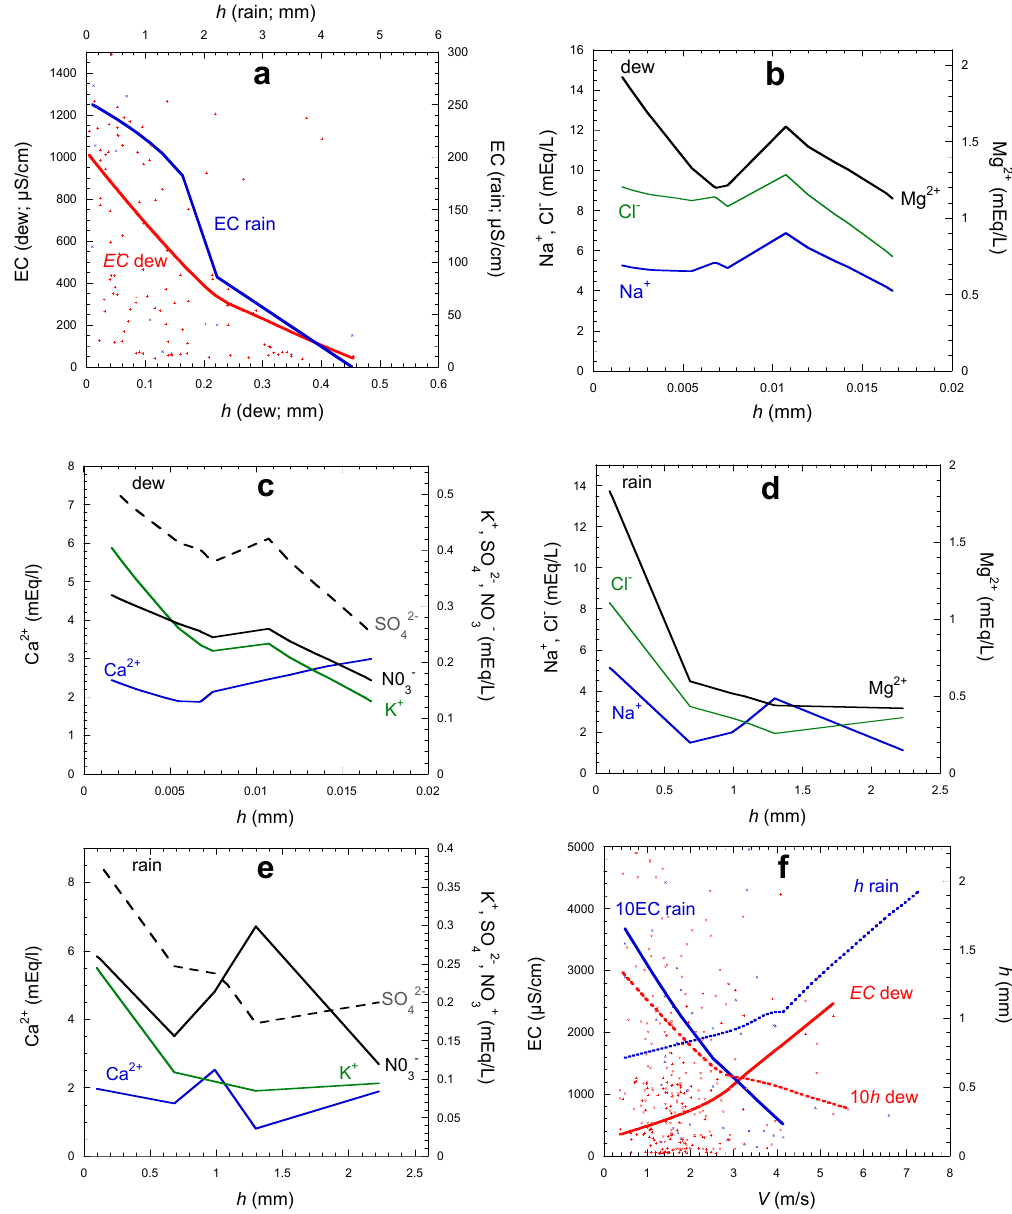
Figure 14. ( a ) Variation of dew and rain electric conductivity EC with dew or rain volume per unit surface area, h (mm). Dew: red, lower abscissa; rain: blue, higher abscissa. ( b ) Correlations with h of the sea salts concentrations in dew (Na + , Cl − : left ordinate; Mg 2+ : right ordinate). ( c ) Same, but with continental ions concentrations (Ca 2+ : left ordinate; K + , NO 3 − , SO 42 − : right ordinate). ( d ) Same as ( b ) for rain ions of sea origin. ( e ) Same as ( c ) for rain ions of continental origin. ( f ) Correlated variations of EC and h with wind speed V at 10 m elevation for dew and rain. All curves in ( a – f ) are smoothed fit of single